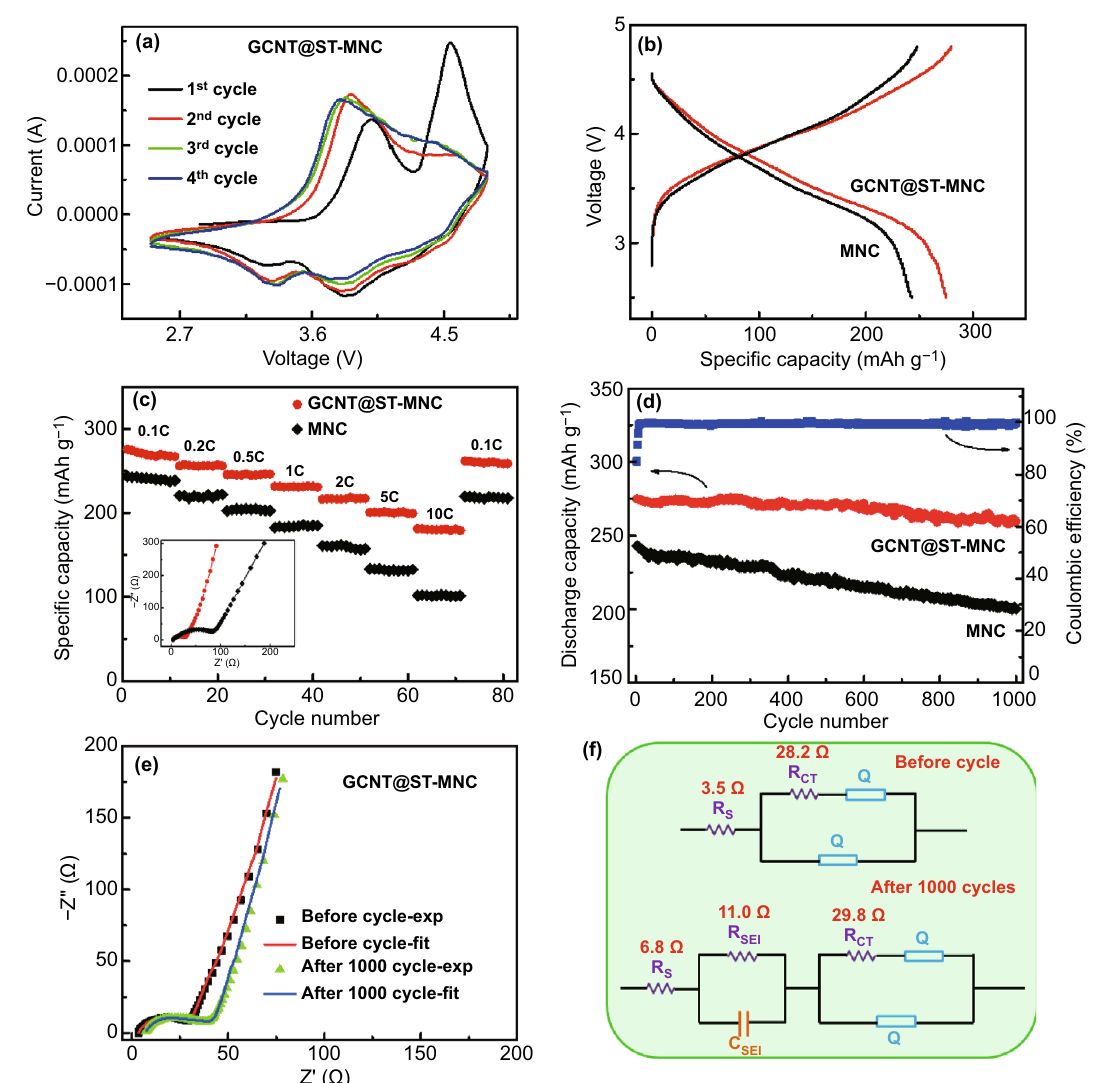
Fig. 4 Electrochemical performance of MNC and GCNT@ST-MNC half cells. a CV curves of GCNT@ST-MNC from 1st and 4th cycle at 0.1 mV s −1 . b Galvanostatic charge/discharge curves at 0.1 C. c Rate performance at various rates from 0.1 to 10 C (the inset is EIS measure- ment). d Cycling performance at 0.1 C (Coulombic efficiency of GCNT@ST-MNC). e EIS of GCNT@ST-MNC before cycle and after 1000 cycles with experimental and fitting data. f Equivalent circuits for EIS fitting of GCNT@ST-MNC before cycle and after 1000